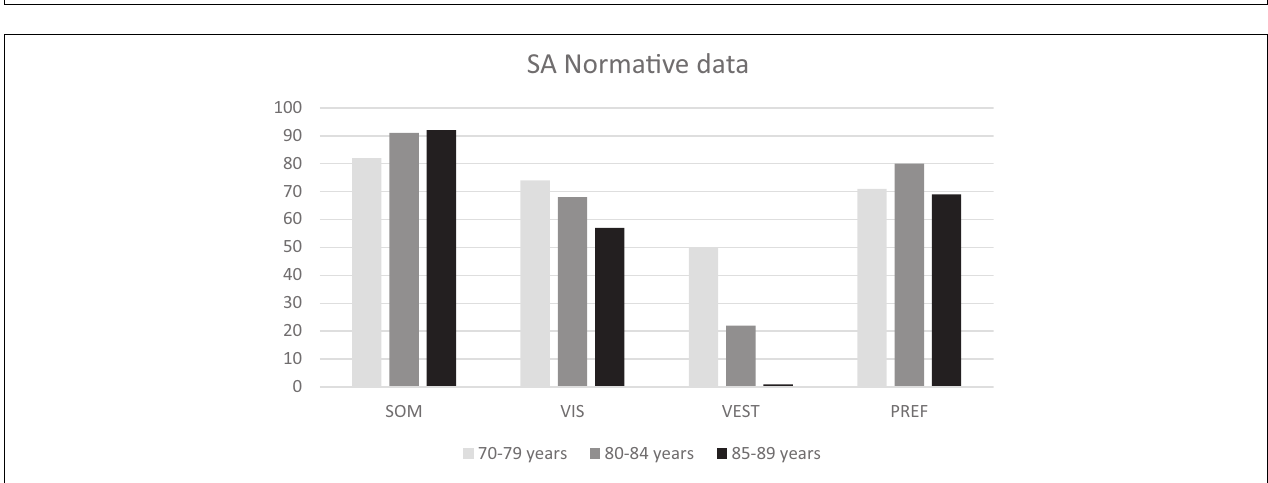
FIGURE 4 | Normative data for sensory analysis (SA) for the three age groups considered in this study. Data for the 70–79 age group are provided by NeuroCom R (cid:13) International Inc.